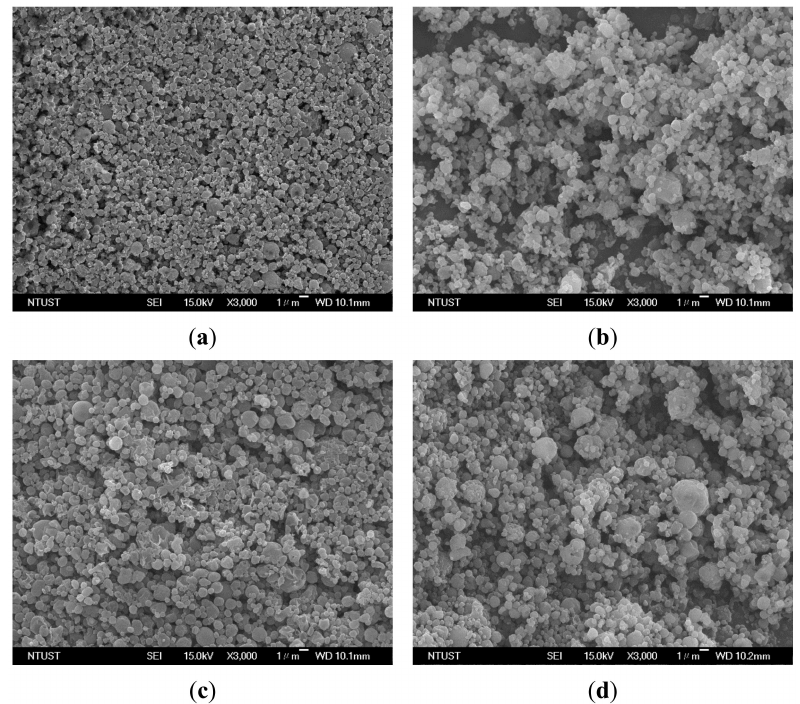
Figure 4. FESEM images of PEG particles produced by the LTSAA process at di ff erent concentrations of the PEG solution ( C ): ( a ) C = 10 mg / mL; ( b ) C = 20 mg / mL; ( c ) C = 30 mg / mL; ( d ) C = 50 mg / mL.